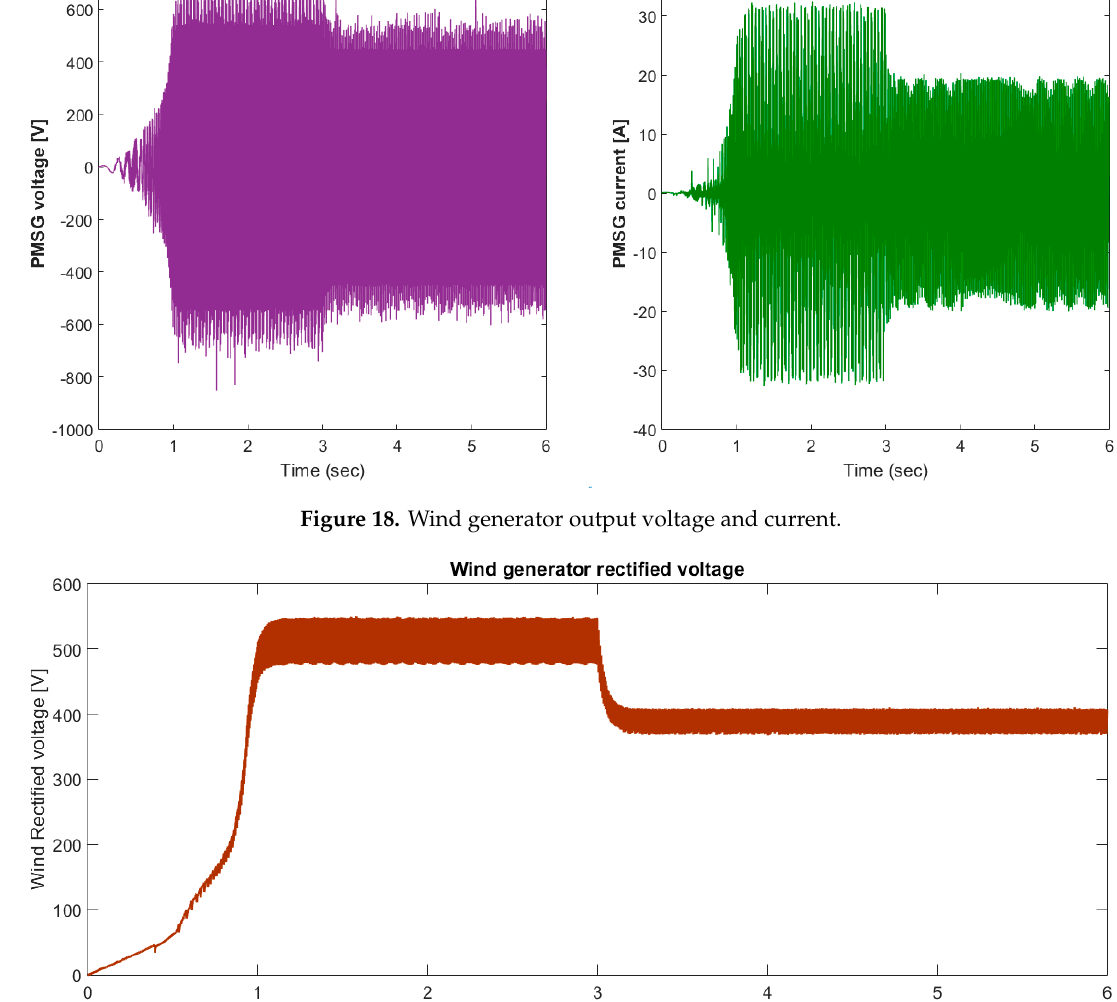
Figure 19. The rectified voltage of PMSG output.